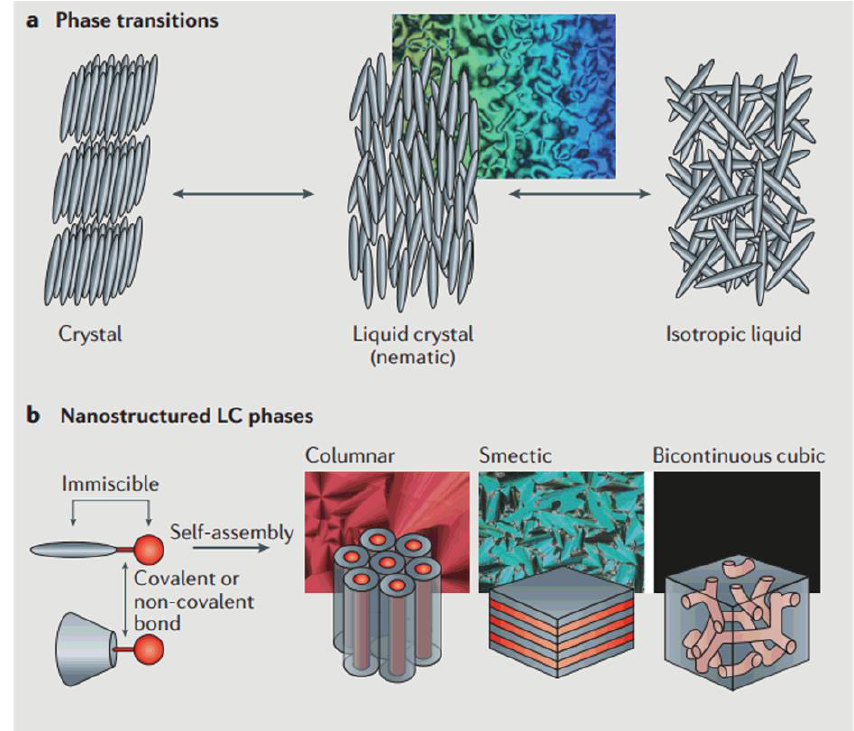
Figure 1. ( a ) Phase transitions and ( b ) nanostructured phases of liquid crystals. Reproduced with permission [21]. Copyright 2017, Nature.